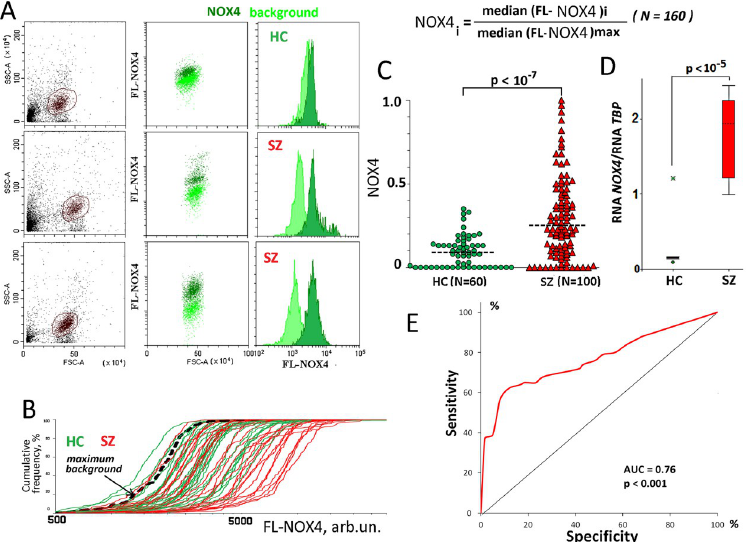
Fig 1. NOX4 levels in the PBL of the SZ and HC groups. A. The most typical examples of the NOX4 analysis in lymphocytes. B. Cumulative distribution of FL1- NOX4 for 63 randomly selected HC (green) and SZ (red) samples in a one experiment. The dashed curve is the background curve for the sample with the maximum background level. C. NOX4 levels in the lymphocyte of the SZ and HC groups. The average level of marker in the cell population was estimated by the FL-signal median value. In the graphs, each point is the mean for three FL-signal median values (three parallel measurements for the same PBMC sample). The median values were normalized to the maximum signal medians values in the analyzed total sample (N = 160). The relative standard error was 7 ± 3%. The significance of the observed differences was analyzed using non-parametric Mann–Whitney (p) test. D. RNA NOX4 levels determined in lymphocytes of 30 SZ patients and 30 HC. E. ROC curve for the SZ/HC groups. Each point on the ROC curve represents a sensitivity/specificity pair. The area under the ROC curve (AUC) is a measure of how well a parameter can distinguish between two groups